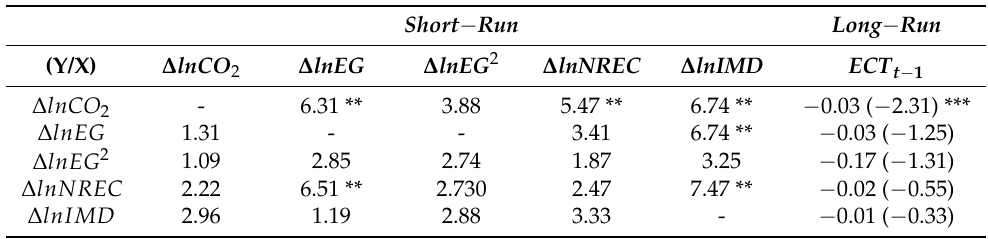
Table 7. Findings of granger